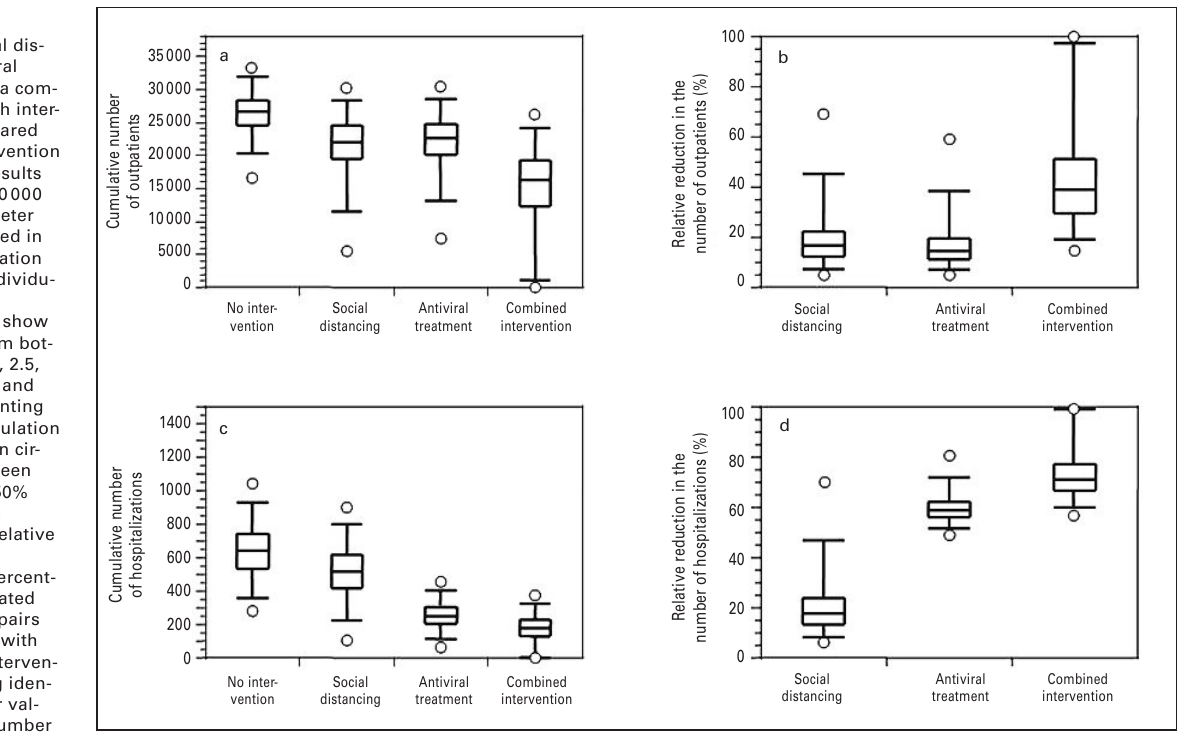
deterministic simulator allows translating input uncertainty into expected output variability. The wide regions of tolerance for the total number